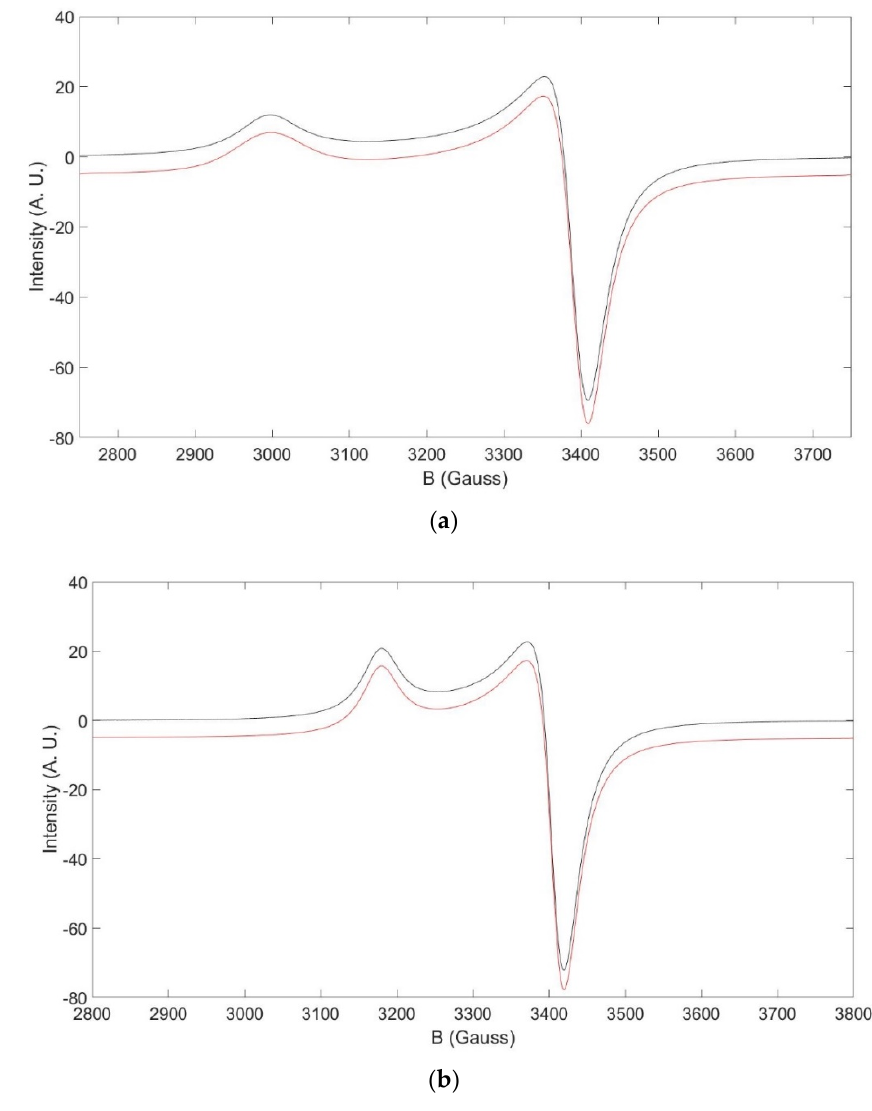
Figure 7. The X-band powder EPR spectra of 1 ( a ) and 2 ( b ) at room temperature with fits shown displaced from the data by −5 intensity units in red.